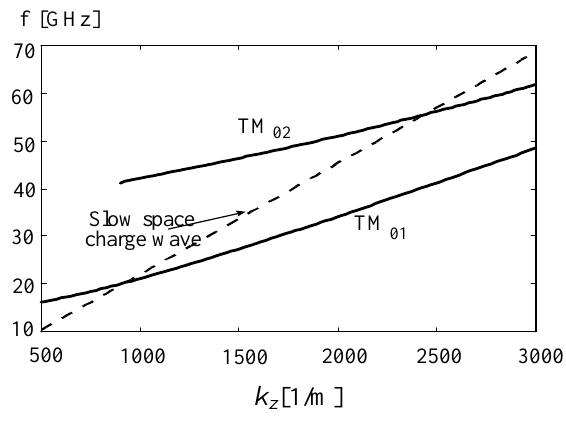
FIG. 2. Dispersion diagram showing the waveguide modes and slow space-charge mode of the electron beam (75 kV, 10 A).